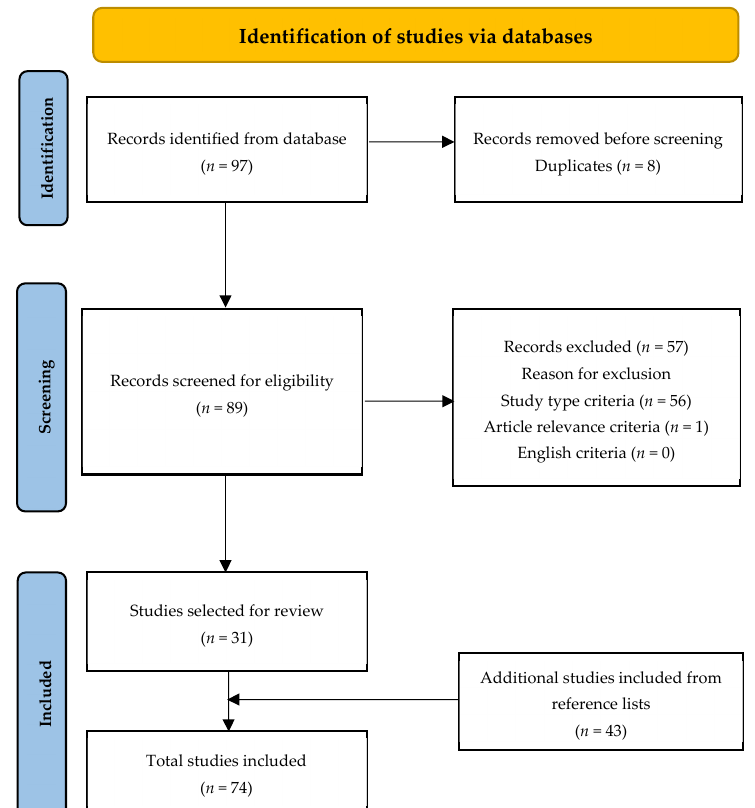
Figure 1. PRISMA flowchart for literature review.